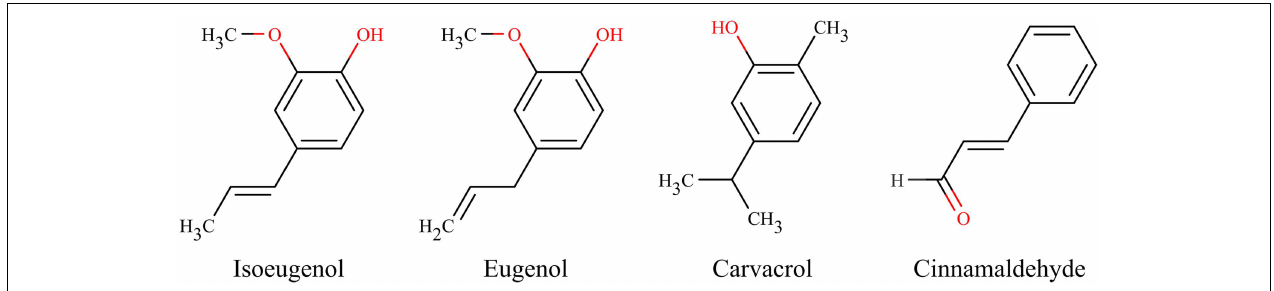
FIGURE 1 | Chemical structures of essential oil